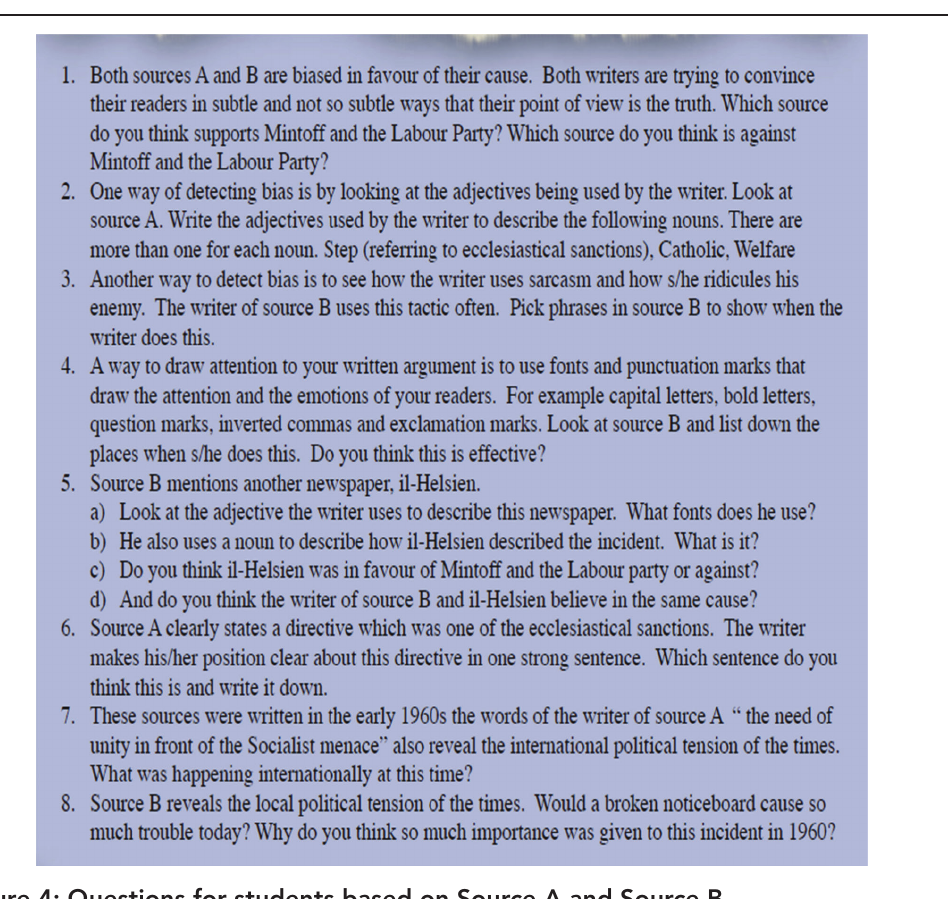
Figure 4: Questions for students based on Source A and Source B Source : Vella (2008: